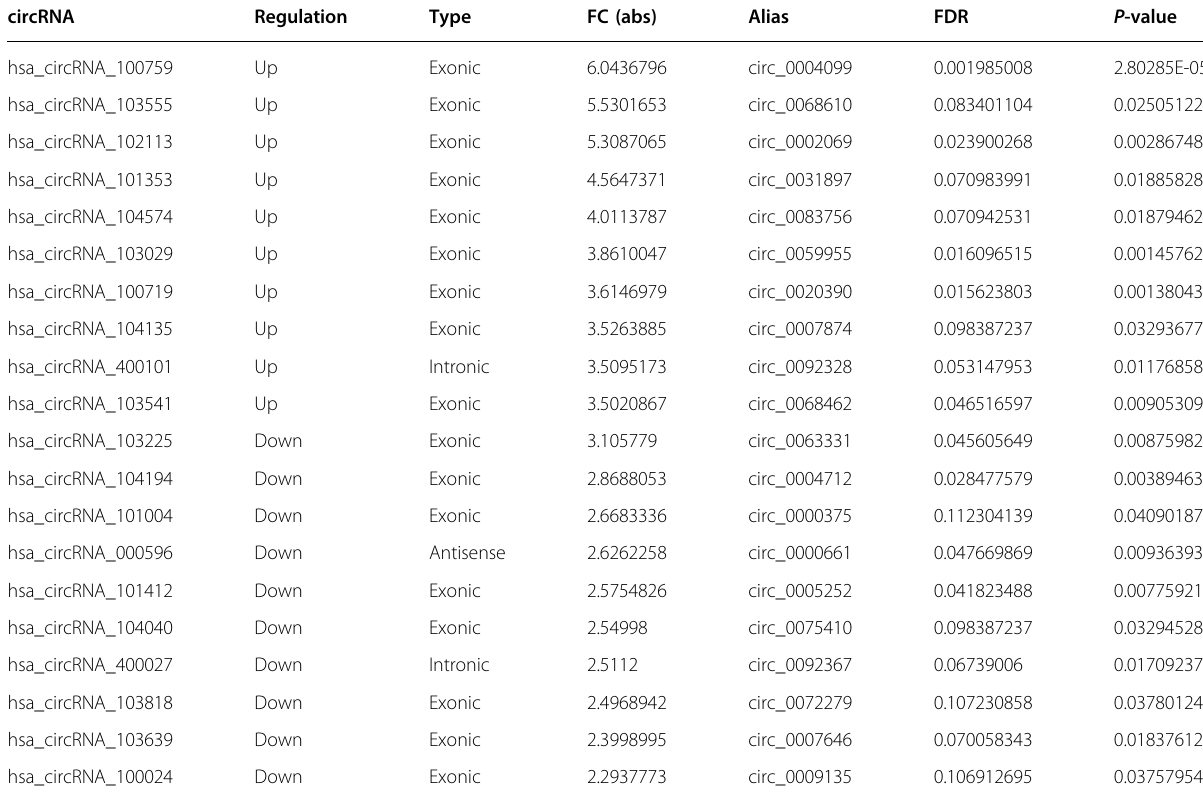
Table 2 Top 10 differentially expressed circRNAs (degenerated vs. non-degenerated) circRNA